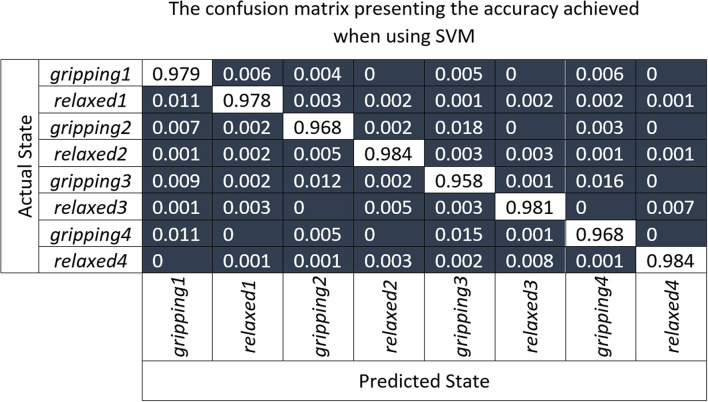
The confusion matrix presenting results of the 10-fold cross-validation of the SVM model which was trained using the principal component transformed features of partial unseen data from all participants.